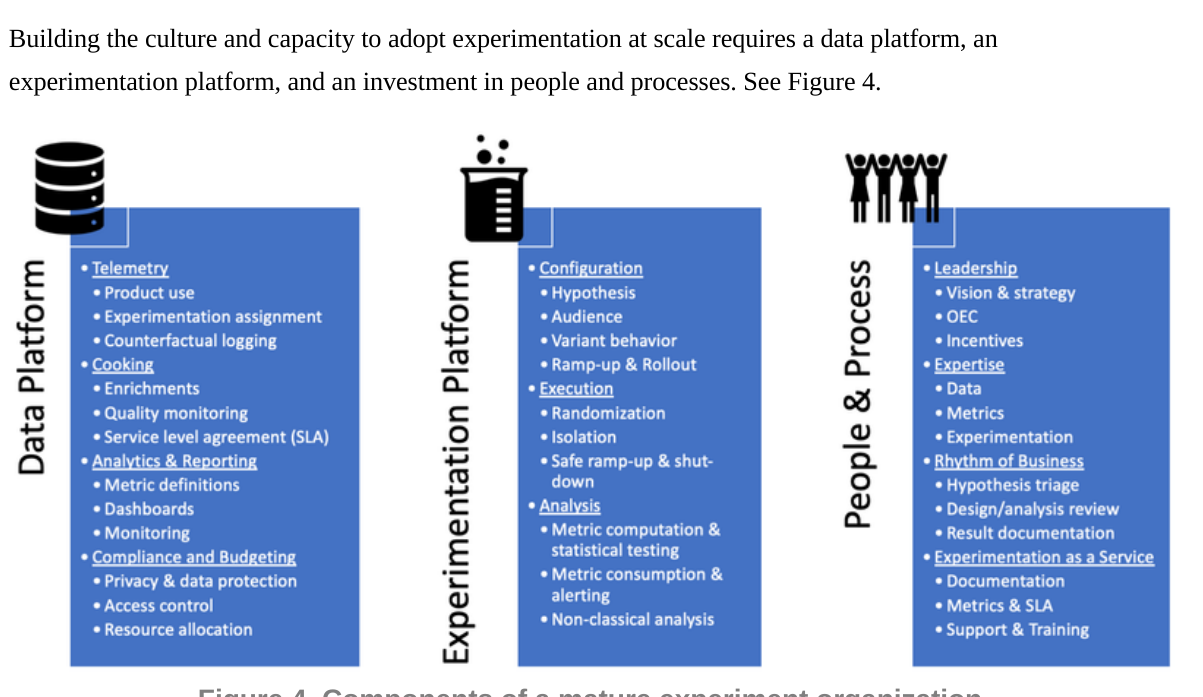
Figure 4. Components of a mature experiment organization